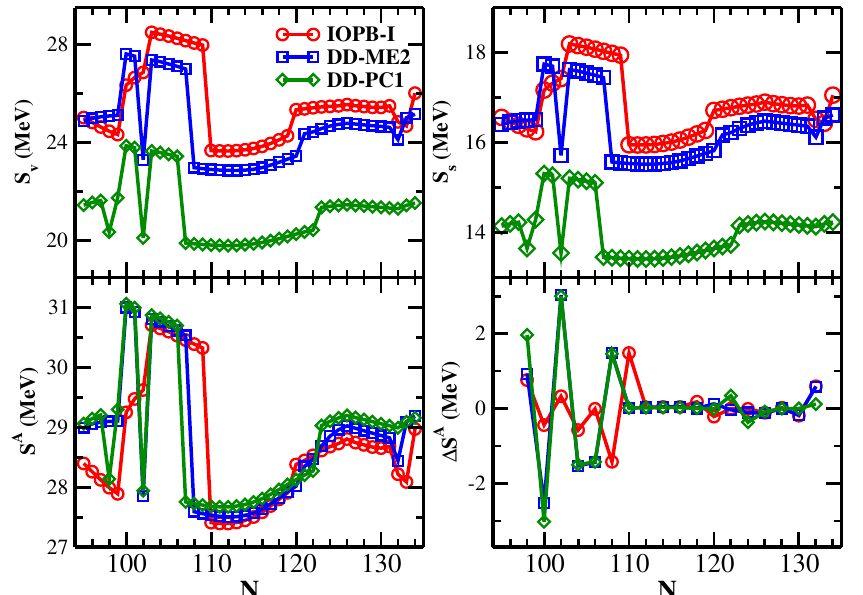
Figure 4. (Color online) The symmetry energy ( S A ) and its volume S V and surface S S components for IOPB-I, DD-ME2 and DD-PC1 parameter sets are shown along with the shift corresponding to the total symmetry energy ( ∆ S A ) for the ground state of Hg-isotopes.